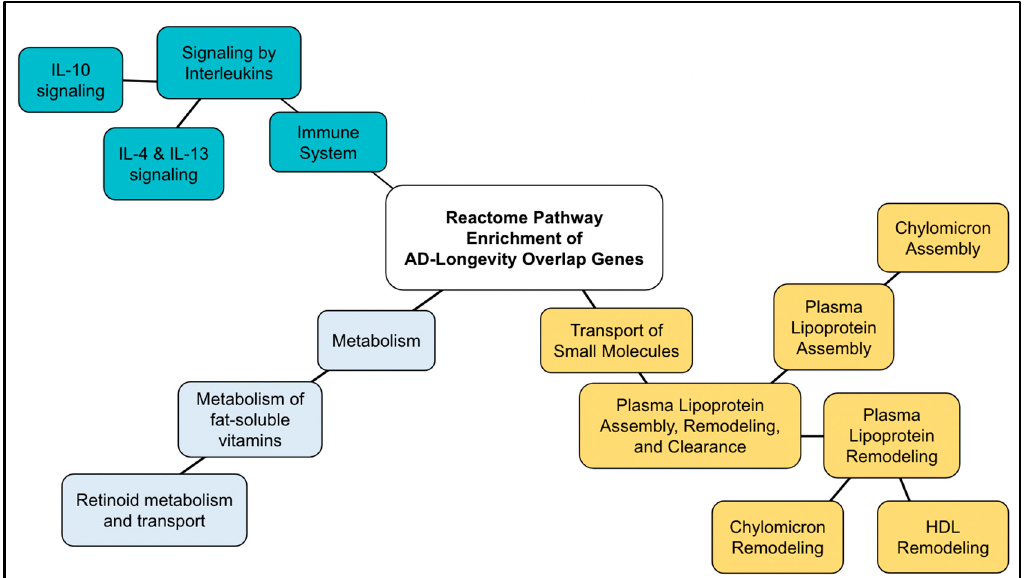
Figure 12. Diagram of the Reactome pathway enrichment of AD–longevity overlap genes. The results shown in Table 6 are summarized.